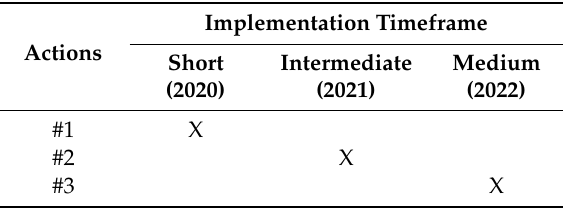
Table 5. Timeframe for the implementation of the Actions. The “X” indicates the type of actions implemented in each time